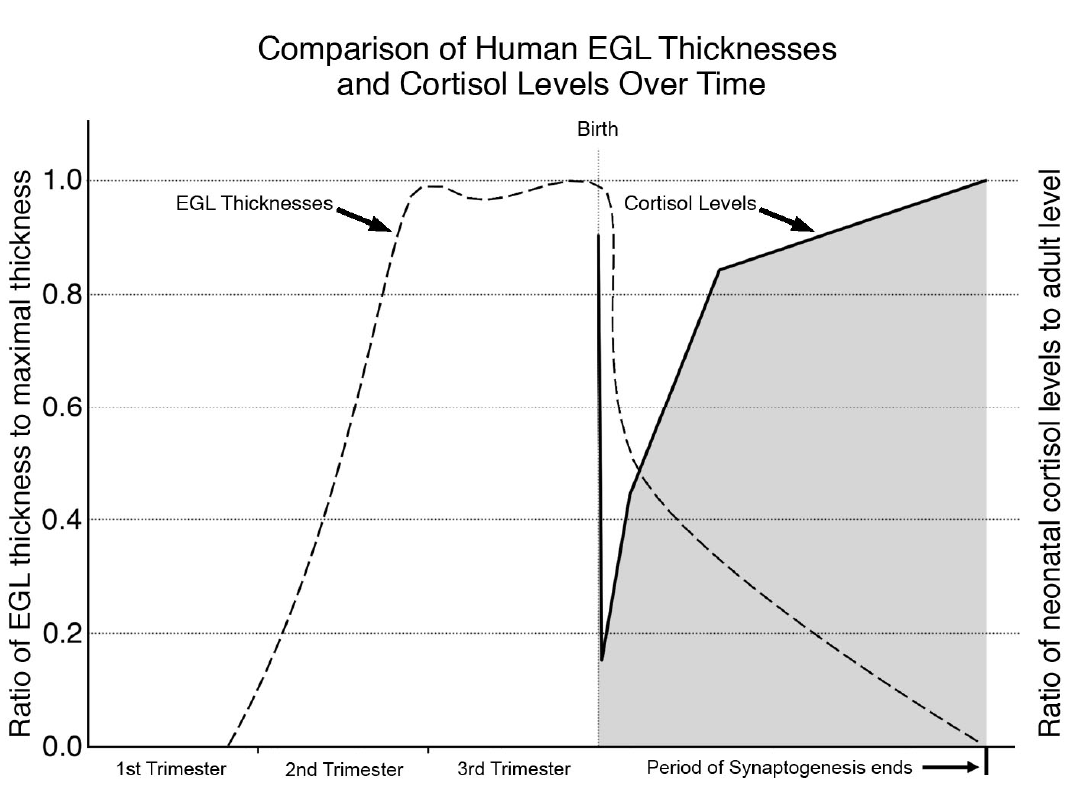
Figure 3. Comparison of human EGL thicknesses and cortisol levels during perinatal development. Graph depicting the thickness of the EGL expressed as a ratio to maximal thickness (dashed line no shading; left) compared to endogenous cortisol levels expressed as a ratio to the adult level (solid line grey shading; right) during perinatal human development. As endogenous cortisol levels naturally surge to adult levels, NPC apoptosis in the EGL increases as this proliferative layer’s thickness decreases rapidly, possibly reflecting cortisol induced apoptosis. Developmental time points are based on a full-term birth occurring at 37 weeks of pregnancy and the period of synaptogenesis ending two years after birth. Calculations of thickness and cortisol ratios are based on data from papers by Rakic & Sidman [31] and Sippell, Dörr, Bidlingmaier, & Knorr [84],